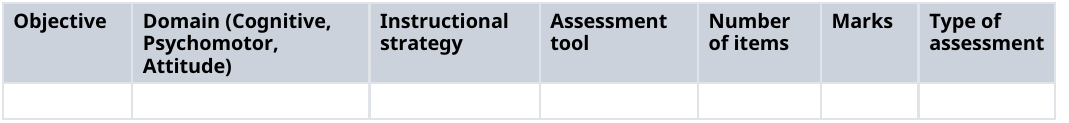
Table 4. Assessment grid for blended